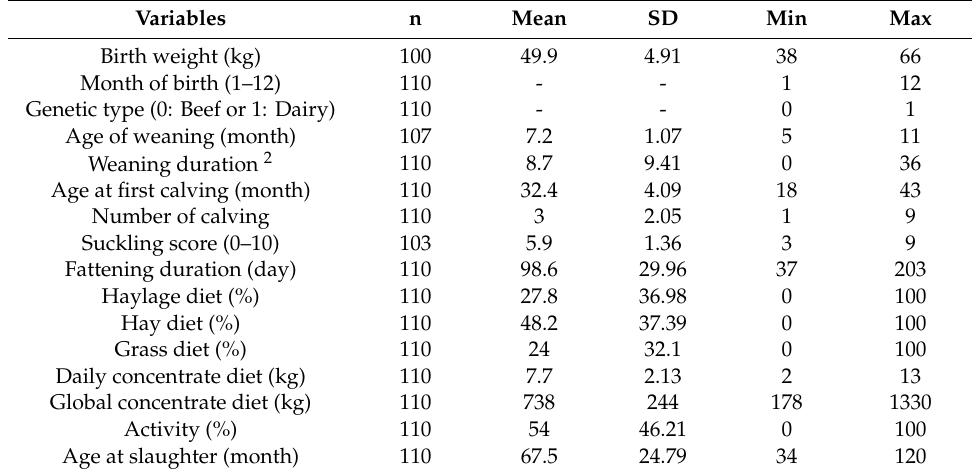
Table 1. Average values and variations of the data from the farm level describing the 16 variables of animal characteristics and finishing period 1 .